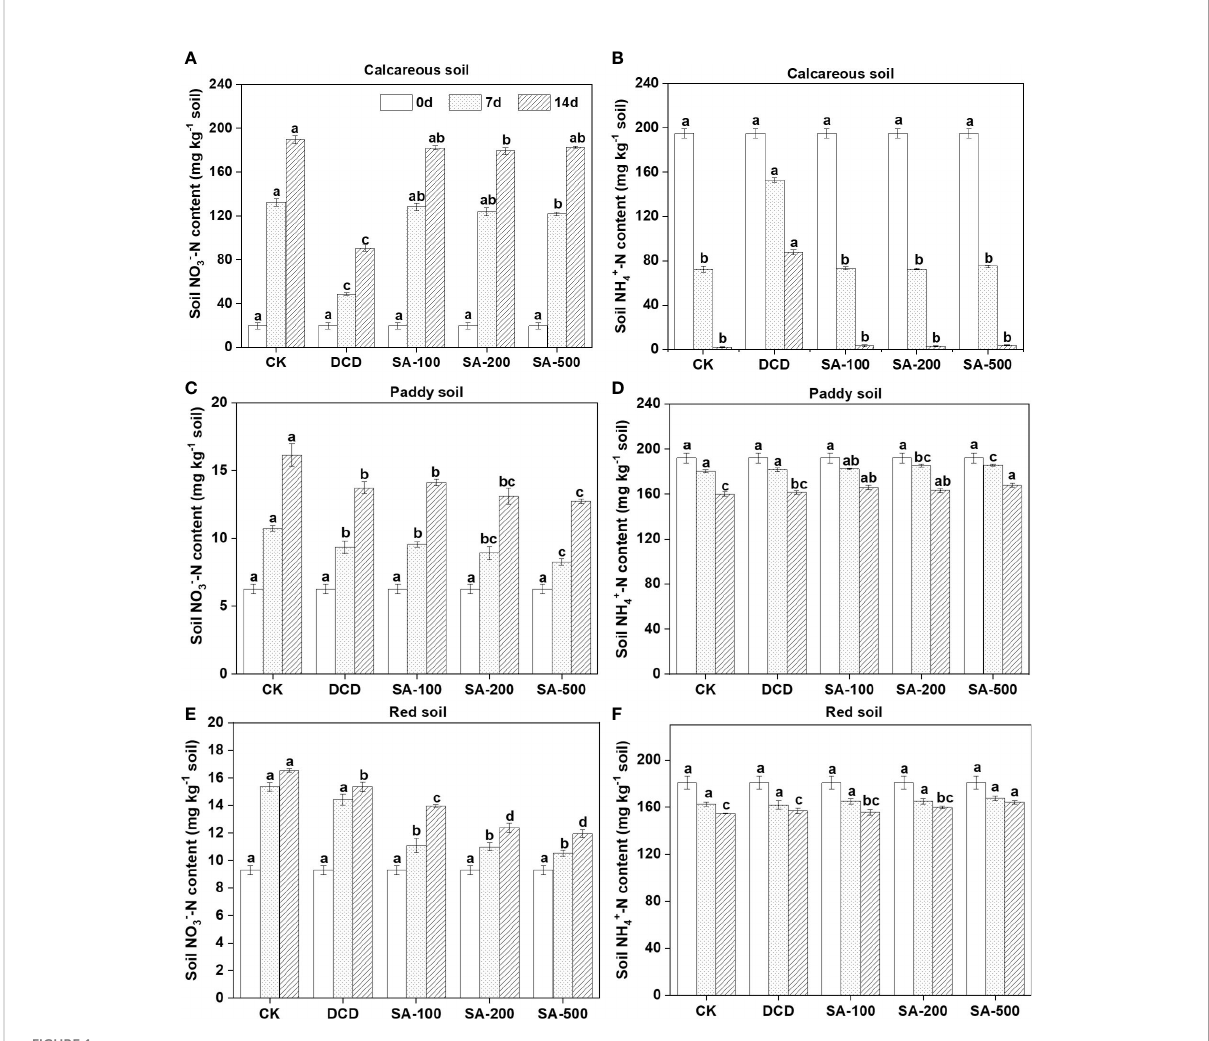
FIGURE 1 Effect of different concentrations of syringic acid (SA) and dicyandiamide (DCD) on soil NO 3- and NH 4+ concentrations in the calcareous (A, B) , paddy (C, D) , and red soil (E, F) during a 14-d incubation. Values are means ± SE (n=3). Different letters indicate signi fi cant differences at P < 0.05 (LSD test) among treatments at each sampling